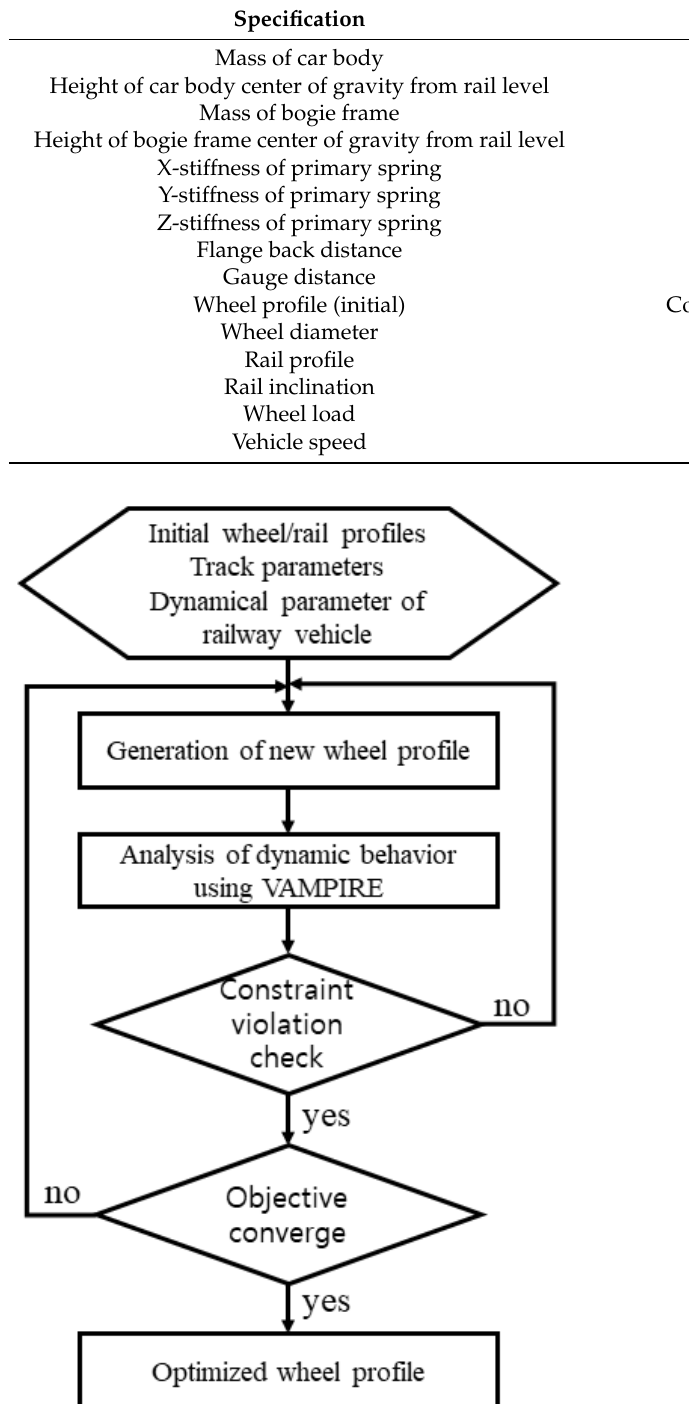
Table 1. Design specification for wheel profile optimization.